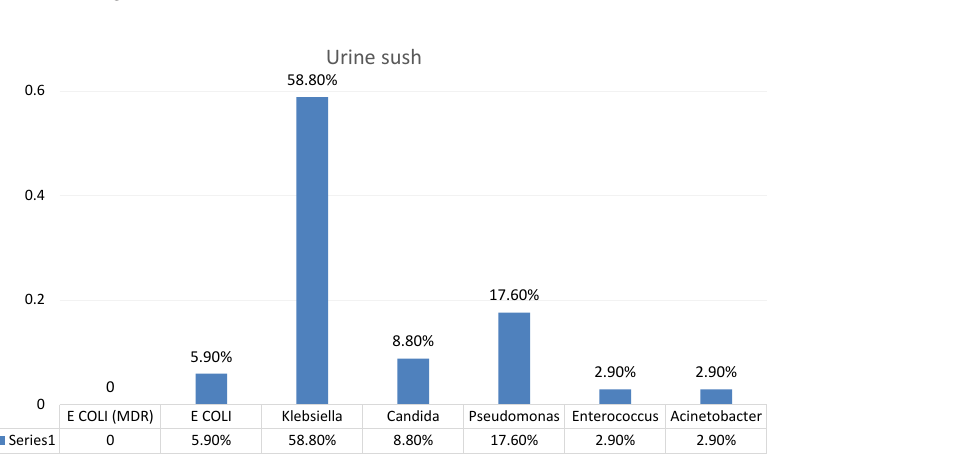
Figure 1. Distribution of urinary tract